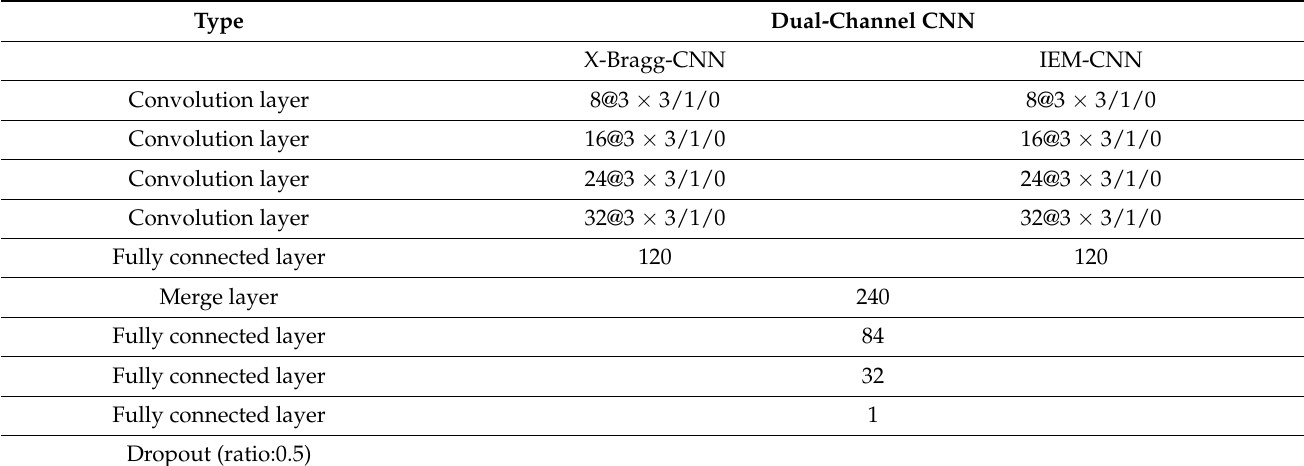
Table 3. Configuration of the regression CNN.